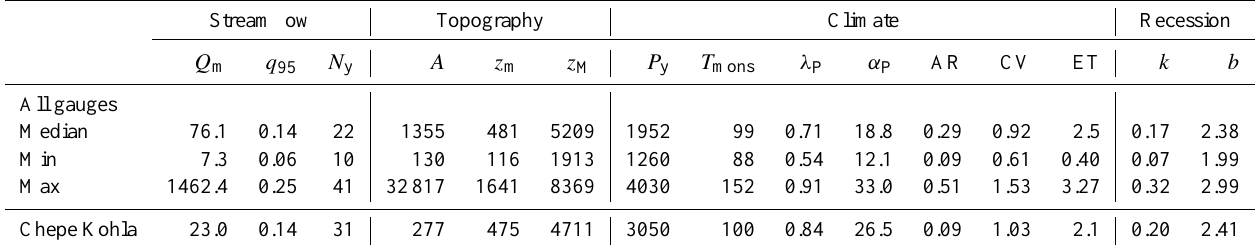
Table 1. Catchment characteristics. Median values and interquartile distances (IQD) are given for the whole sample of 25 gauges. The table also presents characteristics of the Chepe Kohla watershed considered in the analysis as a case study. Streamflow Topography Climate